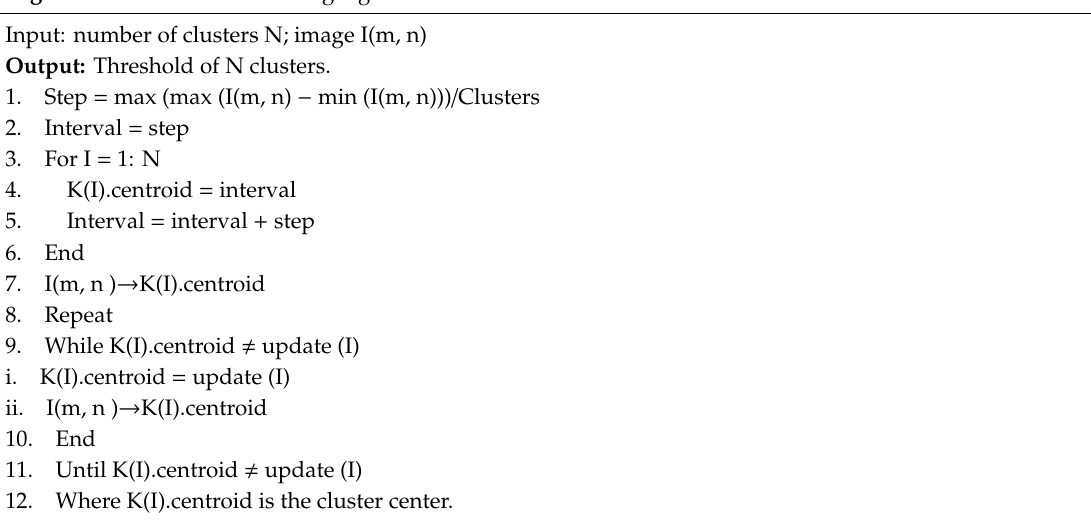
Algorithm 1: K-means clustering